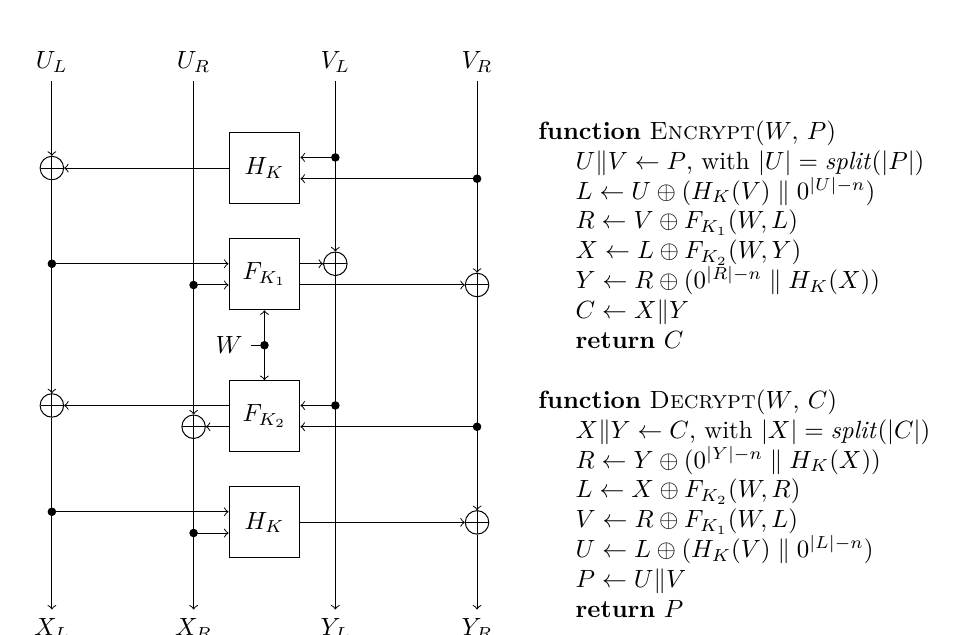
Figure 2: Double-decker tweakable wide block cipher. The parsing of P into states U L , U R , V L , V R , where | U L | = | V R | = n and | U | = split ( | P | ) is not depicted.